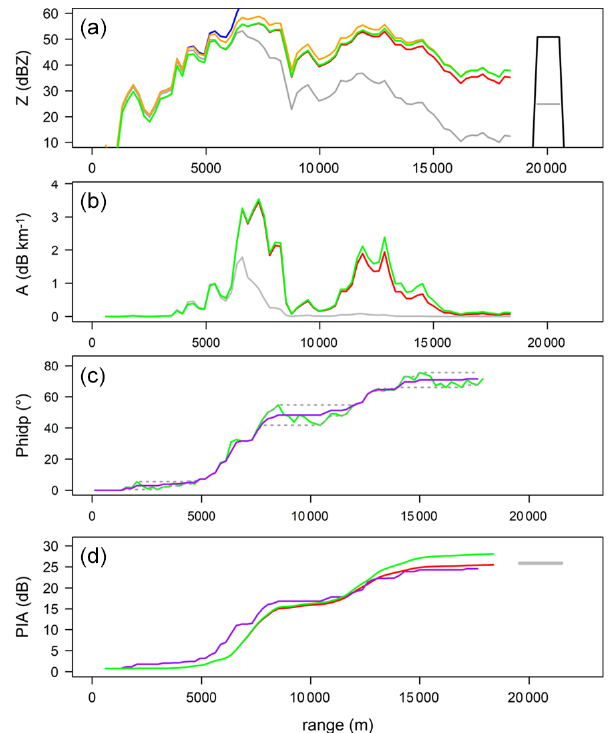
Figure 5. Implementation of the five algorithms (blue – AZ hb; red – AZC ; orange – AZα ; green – AZ 0; purple – PIA φ dp ) for mountain target T13 during the 21 July 2017 convective event at 16:00UTC using a near-optimal parameter set (see text for details). The results are displayed in terms of profiles of (a) reflectivity, (b) specific at- tenuation, (c) differential phase shift on propagation and (d) path- integrated attenuation. The grey profile in panel (a) is the mea- sured reflectivity profile; the black and grey horizontal lines at range 20km represent the mean dry weather baseline and current reflec- tivities, respectively, of the mountain target. The resulting measured PIA value of 25.2dB is reported in grey in panel (d) . The grey pro- file in panel (b) is derived from the measured reflectivity profile by using Eq. (2.5). The purple line in panel (c) is the raw total differen- tial phase shift profile, and the grey dotted curves are the envelope curves used in the regularization procedure (Delrieu et al., 2020; Khanal et al.,